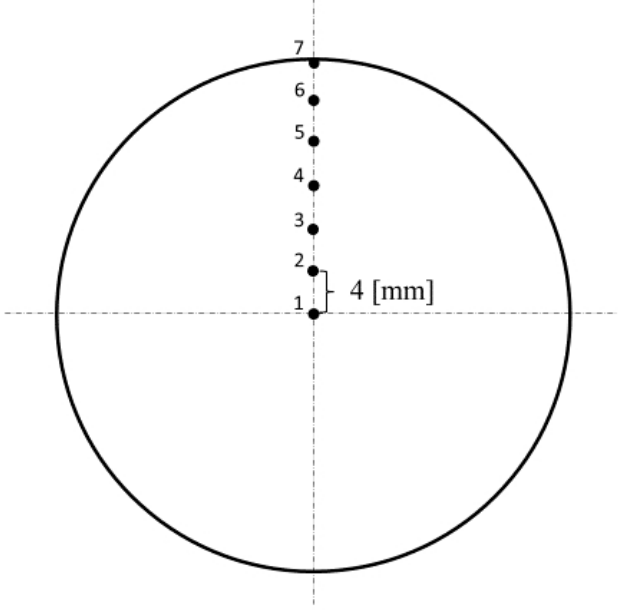
Figure 3. Points on the radius in the cross section of the billet at the stationary stage; the total velocity and accumulated strain calculation was made for these points using QForm software.